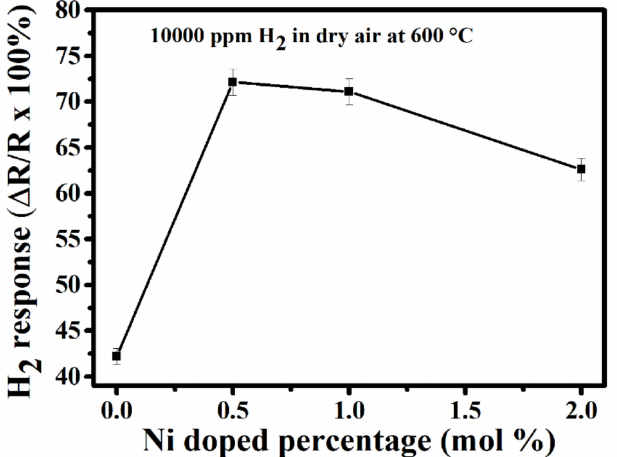
Figure 4. Response of gas sensors based on the co-precipitation synthesized undoped TiO 2 and on all the Ni-doped TiO 2 to 10,000 ppm of hydrogen gas at the optimum operating temperature of 600 ◦ C.